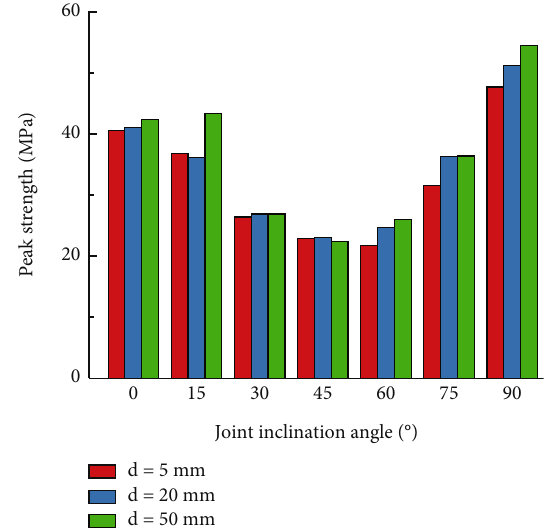
Figure 13: Relation between peak strength of rock and joint inclination angle under di ff erent joint spacing conditions.